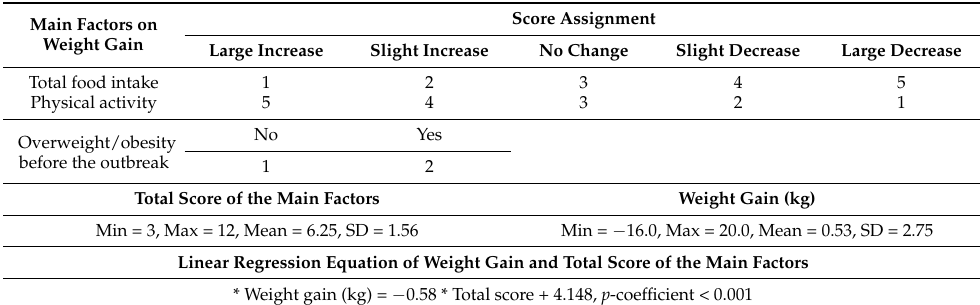
Table 6. Score assignment of the three main factors on weight gain and linear regression equation calculation between the total score of the three main factors and weight gain.